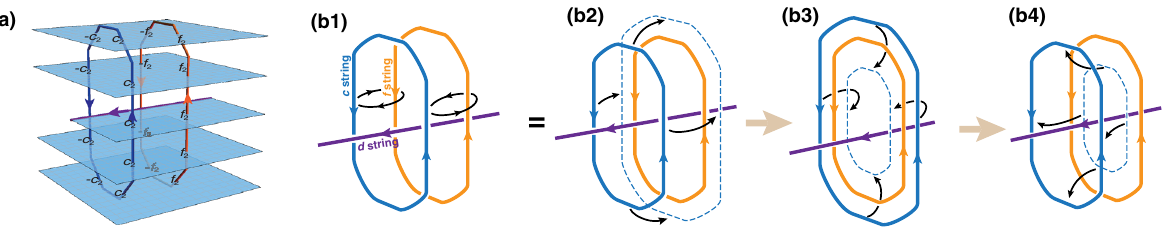
FIG. 10. (a) The configuration of the c string and the f string that link with an edge dislocation (or a d string) which is indicated by the purple line. (b1) The braiding process of the c string and the f string that are both linked with the d string. (b2) – (b4) The decomposed steps in this braiding process.